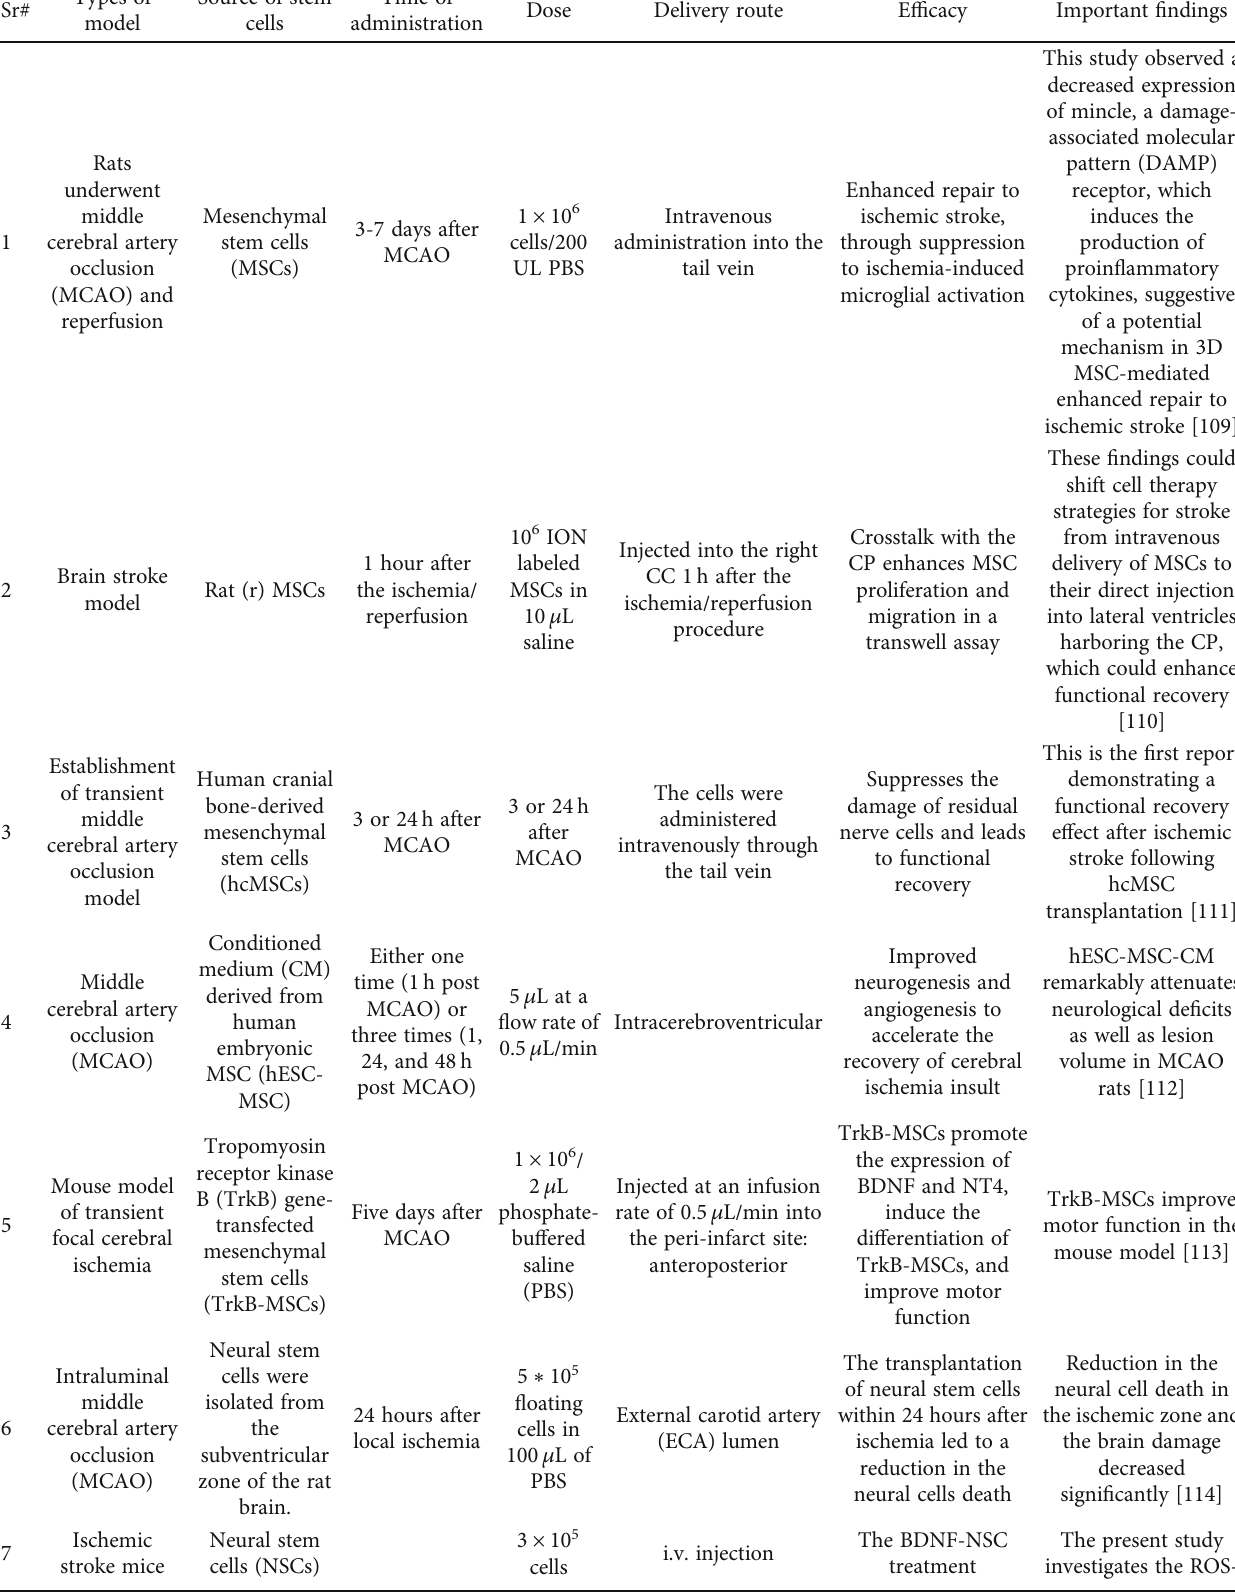
Table 1: Summary of the most recent studies using animal models of ischemic stroke and mesenchymal stem cell therapy.